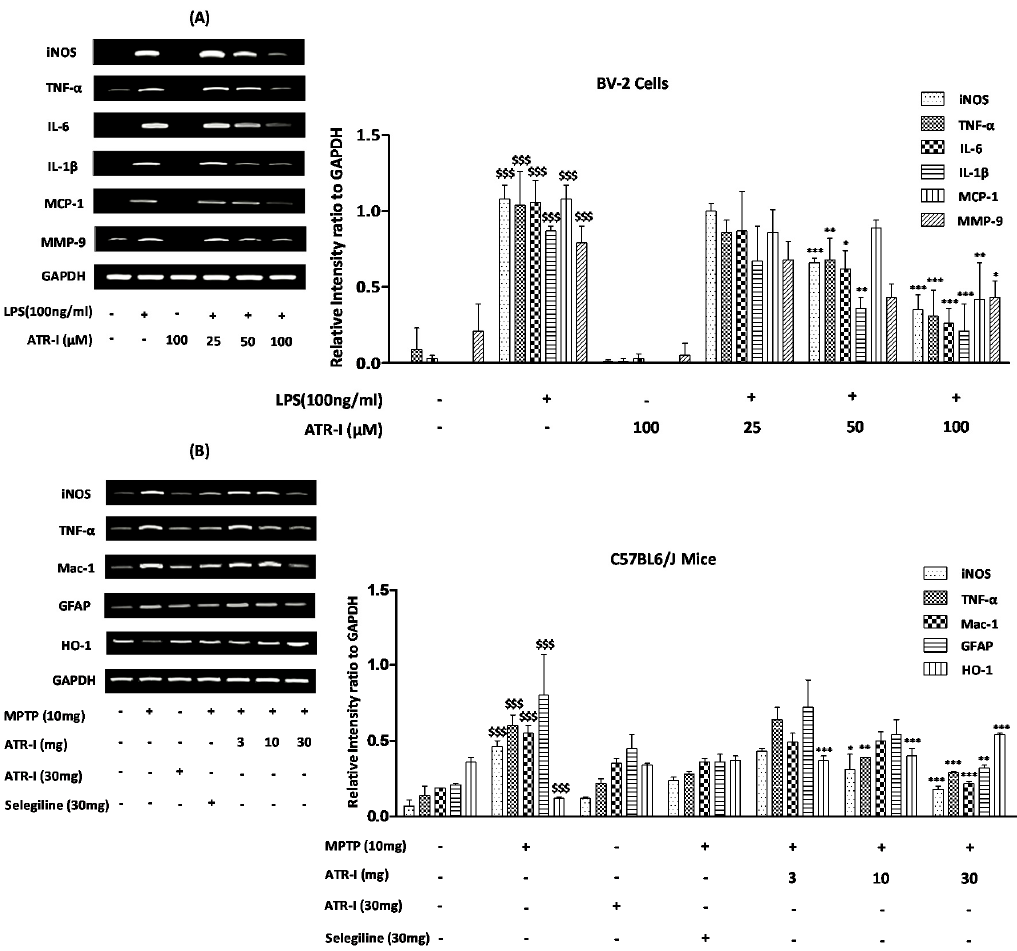
Figure 2. Quantification data are shown in the right panel. ( A ) mRNA levels ( n = 6) of iNOS, TNF- α , IL-6, IL-1 β , MCP-1, MMP-9 in BV-2 cells and ( B ) mRNA levels ( n = 4) of iNOS, TNF- α , Mac-1, GFAP, and HO-1 in mice. GAPDH was used as an internal control. $$$ p < 0.001 vs. vehicle group; * p < 0.05, ** p < 0.01, and *** p < 0.001 vs. LPS and MPTP-treated group.